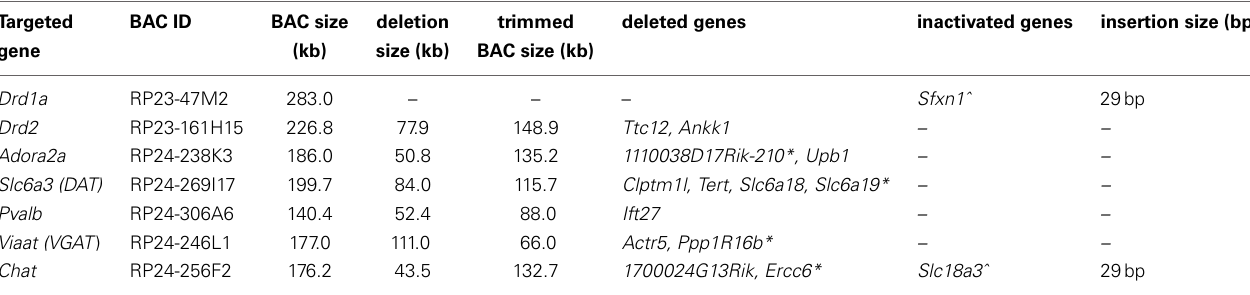
Table 2 | Successfully modified BAC clones using BAC trimming and gene inactivation approaches.